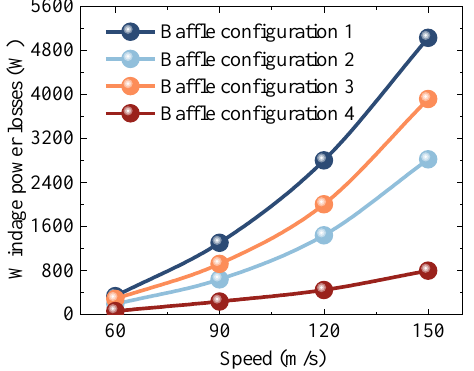
Figure 10. WPL of different baffle configurations.